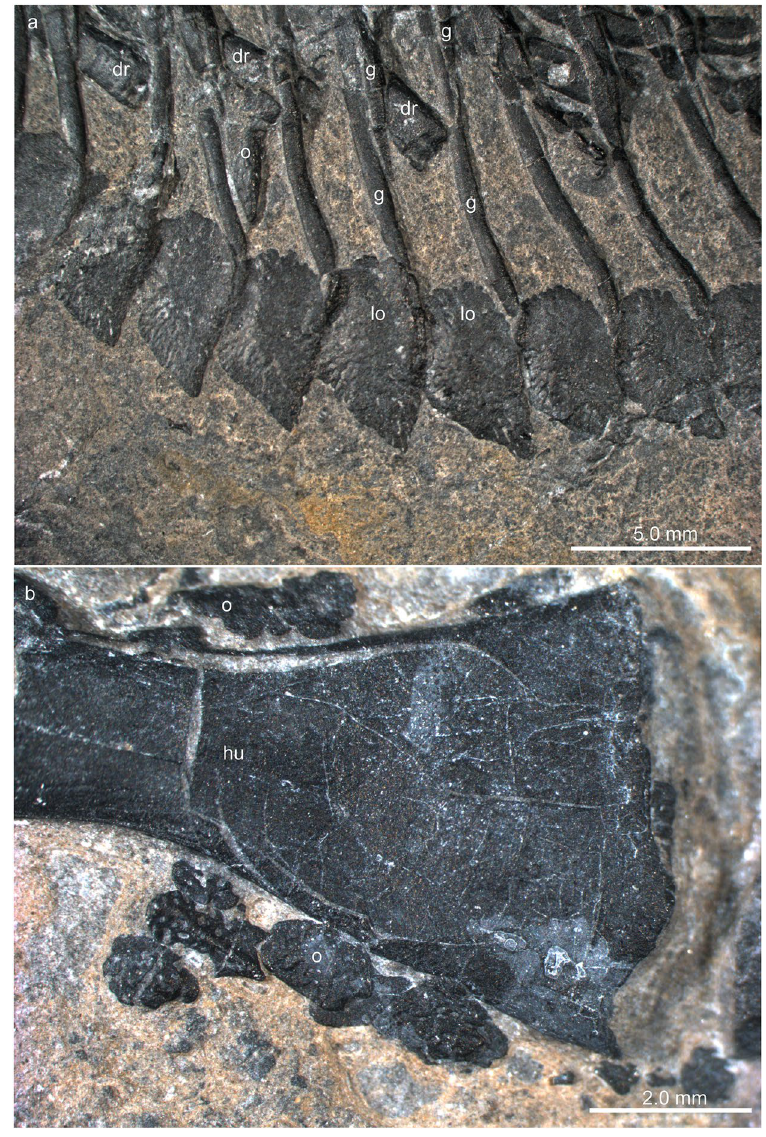
Figure 11. Detail of the dermal armour of Eusaurosphargis dalsassoi (PIMUZ A/III 4380). ( a ) Lateral trunk osteoderms and associated gastralia. ( b ) Distal part of the left humerus with associated pre- and postaxial osteoderms. Note sculpturing pattern and keel of some of the osteoderms. Abbreviations used in the figure are thoracic/dorsal rib (dr), gastralia (g), humerus (hu), lateral osteoderm (lo), and osteoderm